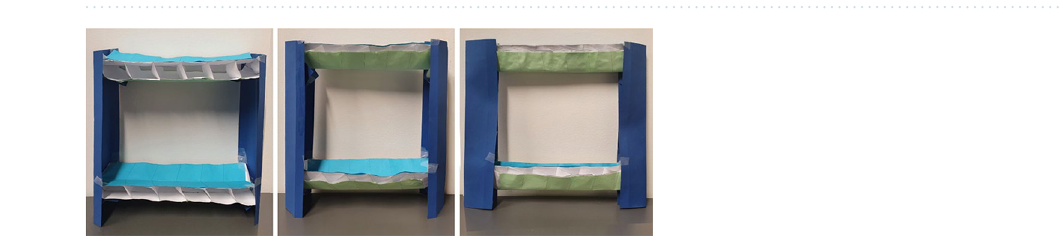
Figure 7. Structural behaviour of an origami-like unit ( a ) and a standard MBS ( b ) under self-weight and uniform gravity load equal to 5 kN/m 2 .